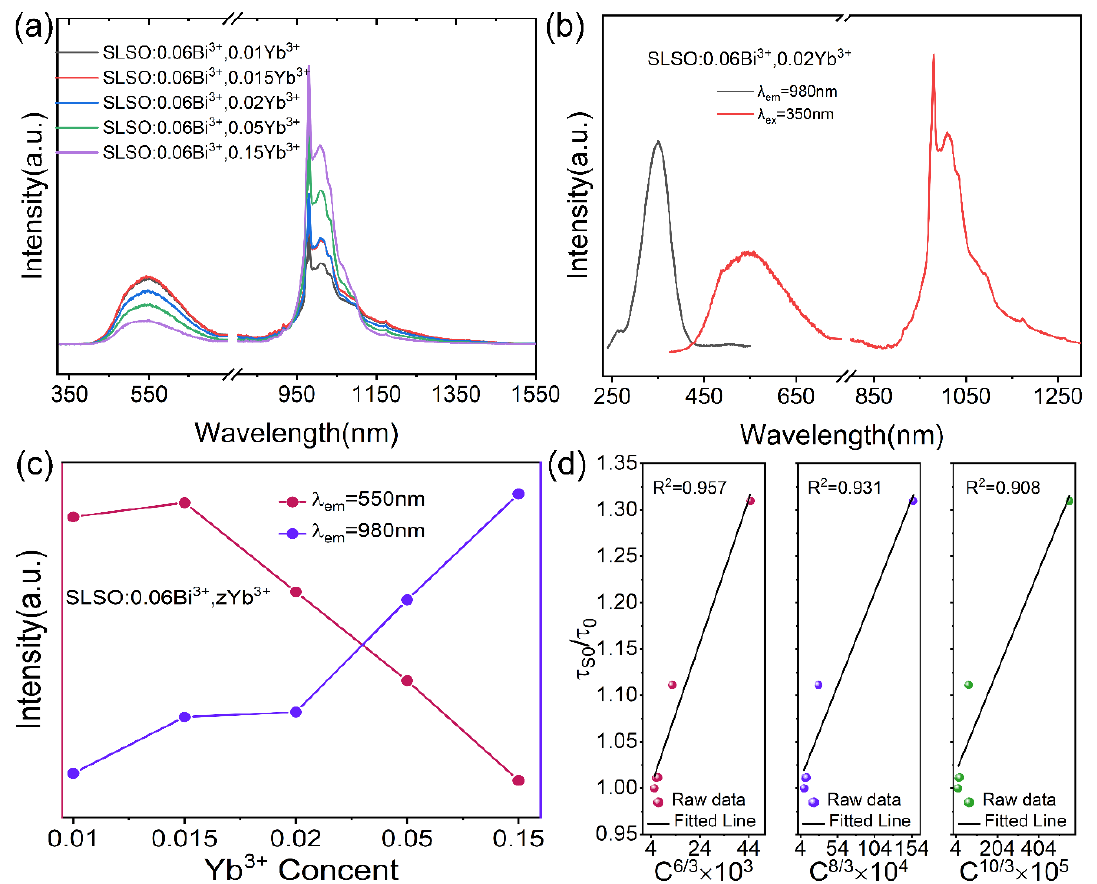
Figure 8. ( a ) Emission spectra of SLSO: Bi 3+ , z Yb 3+ ; ( b ) excitation and emission spectra of SLSO: Bi 3+ , 0.02Yb 3+ ; ( c ) emission intensities of SLSO:0.06Bi 3+ , z Yb 3+ ( λ em = 550 and 980 nm); ( d ) relationship between τ S0 /τ 0 and C 6/3 , C 8/3 , and C 10/3 in SLSO:0.06Bi 3+ , z Yb 3+ .